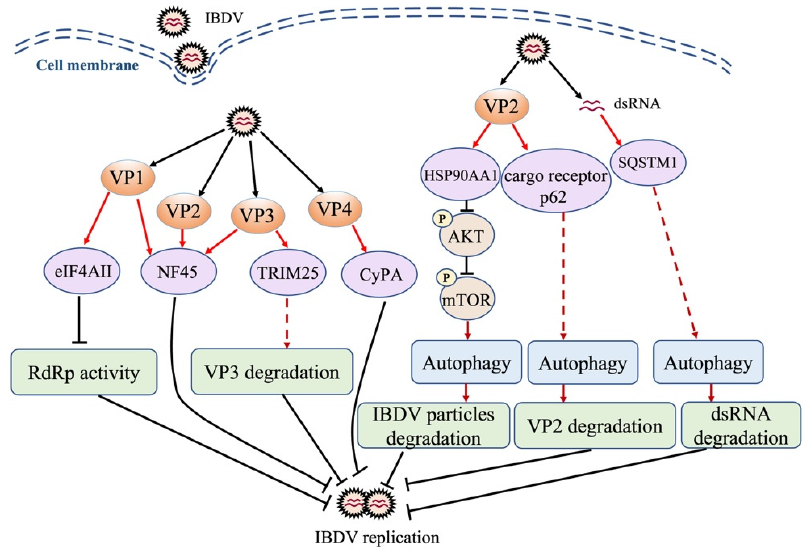
Figure 1. Schematic diagram of the roles of cellular proteins in host response to IBDV infection. IBDV infection triggers host antiviral response, and cellular proteins are involved in this response, inhibiting viral replication via direct interaction with the viral protein or genome. eIF4AII: transla- tional eukaryotic initiation factor 4AII; NF45: nuclear factor 45; TRIM25: tripartite motif 25; CyPA: cyclophilin A; HSP90AA1: heat shock protein 90 AA1; SQSTM1: sequestosome-1; AKT: protein kinase B; mTOR: mammalian target of rapamycin; RdRp: RNA-dependent RNA polymerase protein; dsRNA: double-stranded